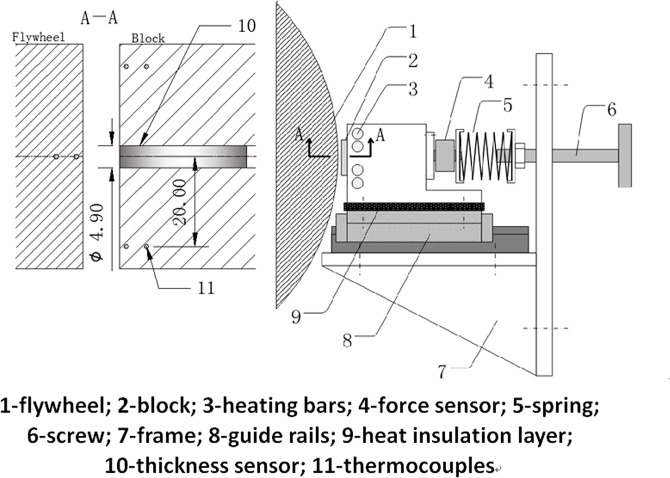
Schematic diagram of the sensors.